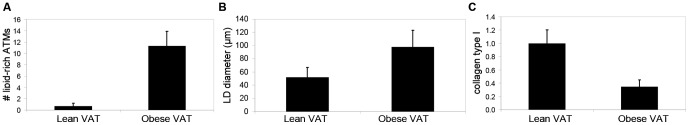
Quantitative analysis of VAT composition in lean and obese mice.(A) Average number of lipid-rich ATMs per analysis volume with xyz dimensions of 250 µm×250 µm×50 µm. (B) Average diameter of lipid droplets of ∼200 adipocytes for lean VATs and ∼100 adipocytes for obese VATs. (C) Normalized level of collagen fibrils type I, as measured by SHG intensity, in the VATs of lean and obese mice. Data was normalized to 1 for lean VATs and respectively for obese VATs. Error bars represents standard deviation across 81 volumes analyzed.